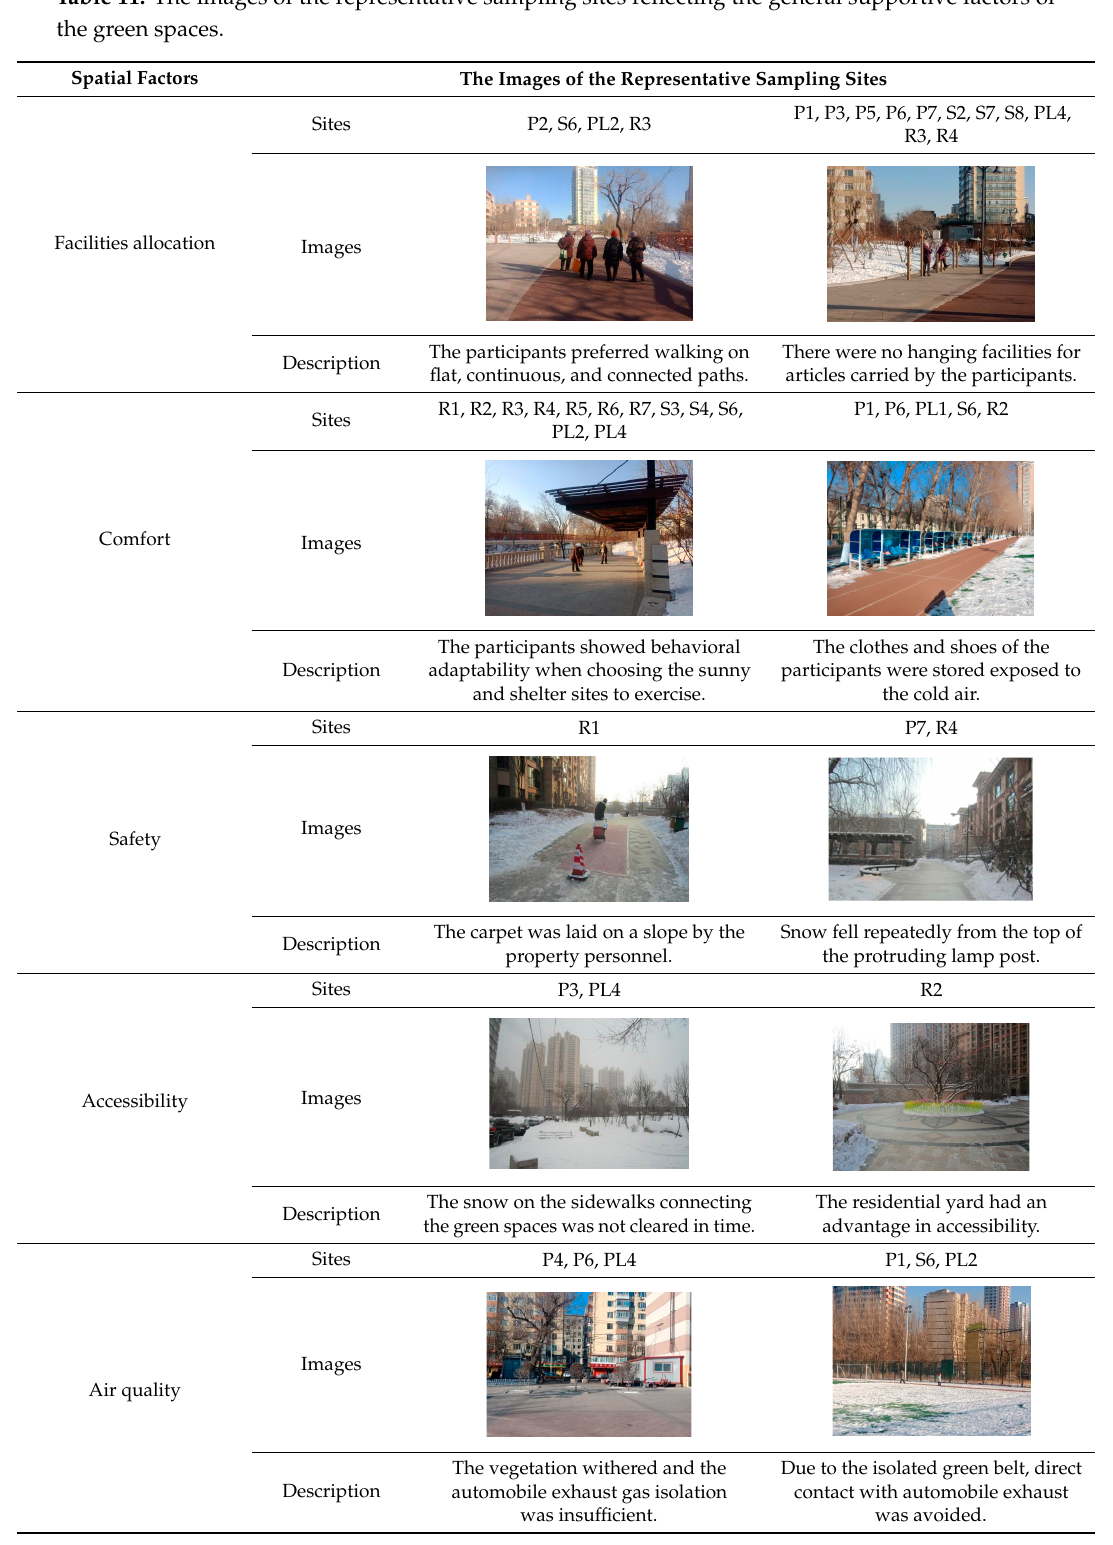
Table 11. The images of the representative sampling sites reflecting the general supportive factors of the green spaces.